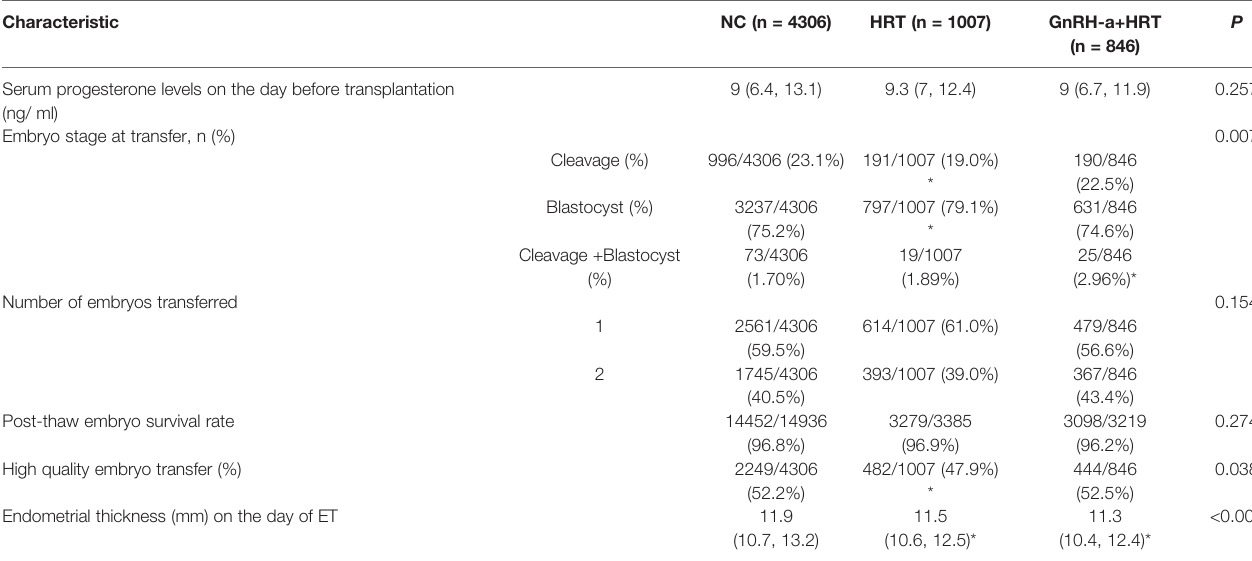
TABLE 2 | Cycle characteristics during the embryo transfer.